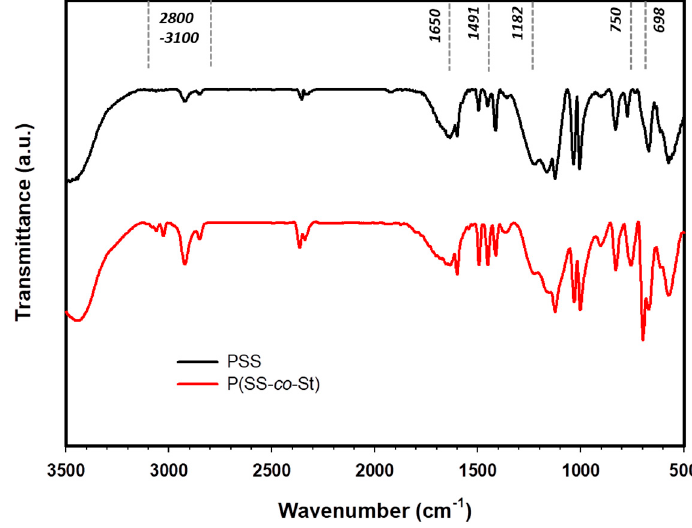
Figure 2. FT–IR spectra of PSS and P(SS-co-St) polymers.